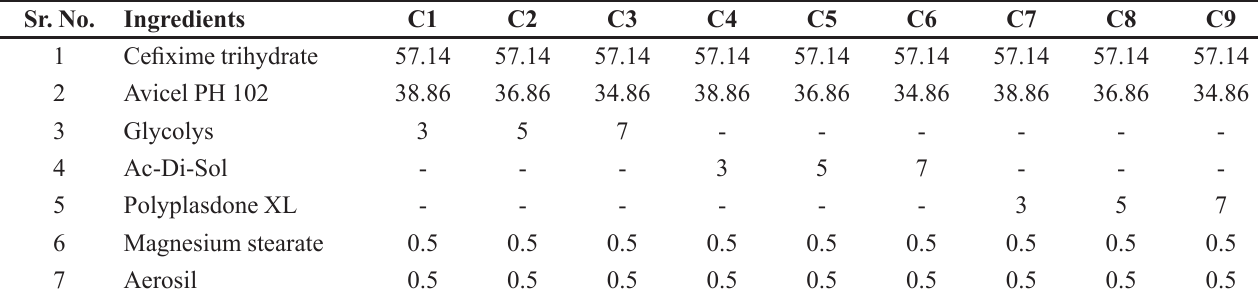
TABLE II - Composition (%w/w) of cefixime trihydrate IR tablets (350 mg) Sr.